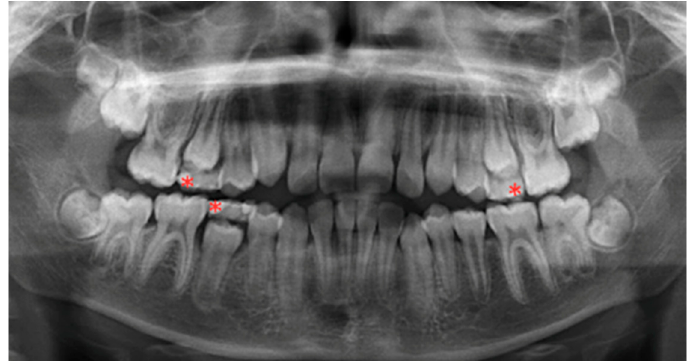
Figure 2. Orthopantomograph of a child in mixed dentition. * demonstrated primary teeth with the successor premolar in the Nolla’s stage 8; however, no alveolar crypt was observed, and teeth were not considered PPT.